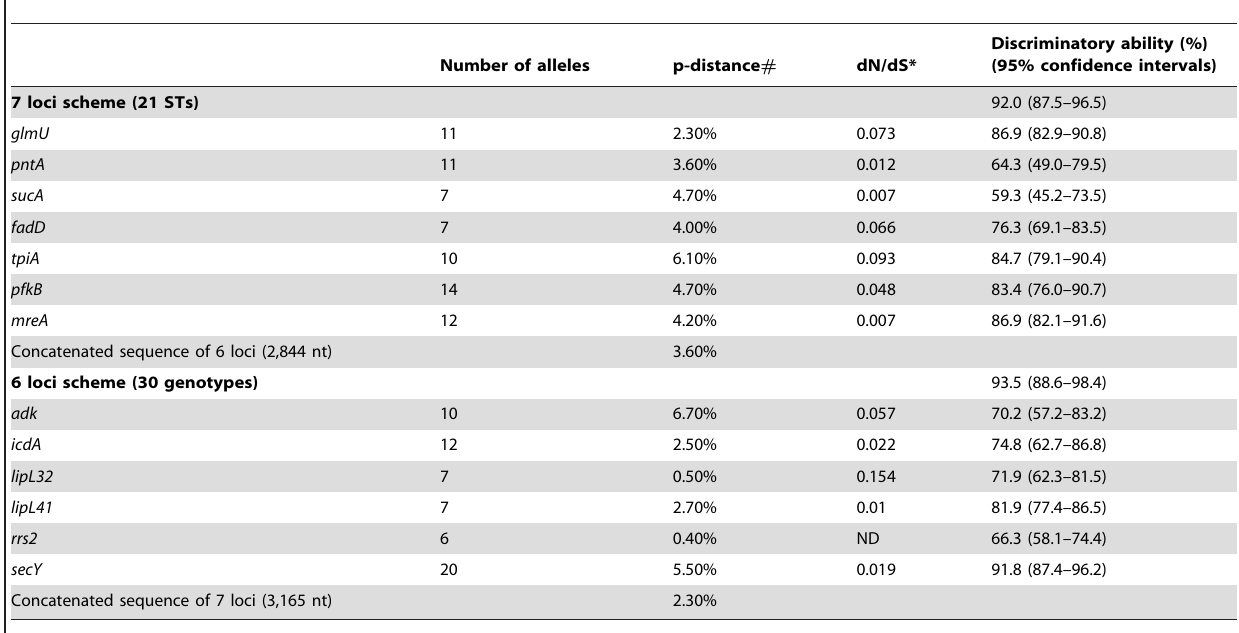
Table 3. Discriminatory ability of two genotyping schemes and their respective loci.